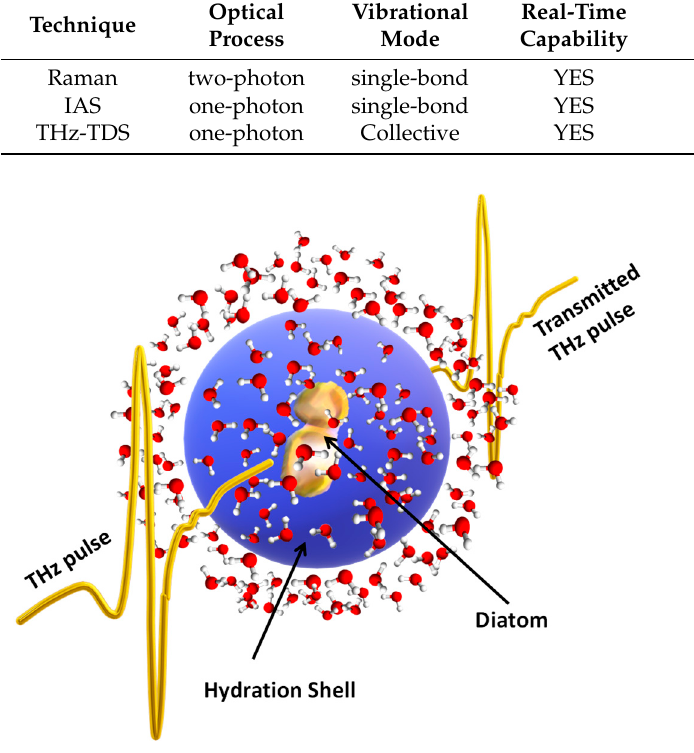
Figure 1. The principle of THz-TDS: a sub-picosecond THz pulse passes through the sample, here formed of diatoms in water. The transmitted pulse is attenuated and delayed because of the absorption coefficient and the refractive index of the sample. Therefore, it carries information on these two parameters at all the frequencies composing the pulse bandwidth.